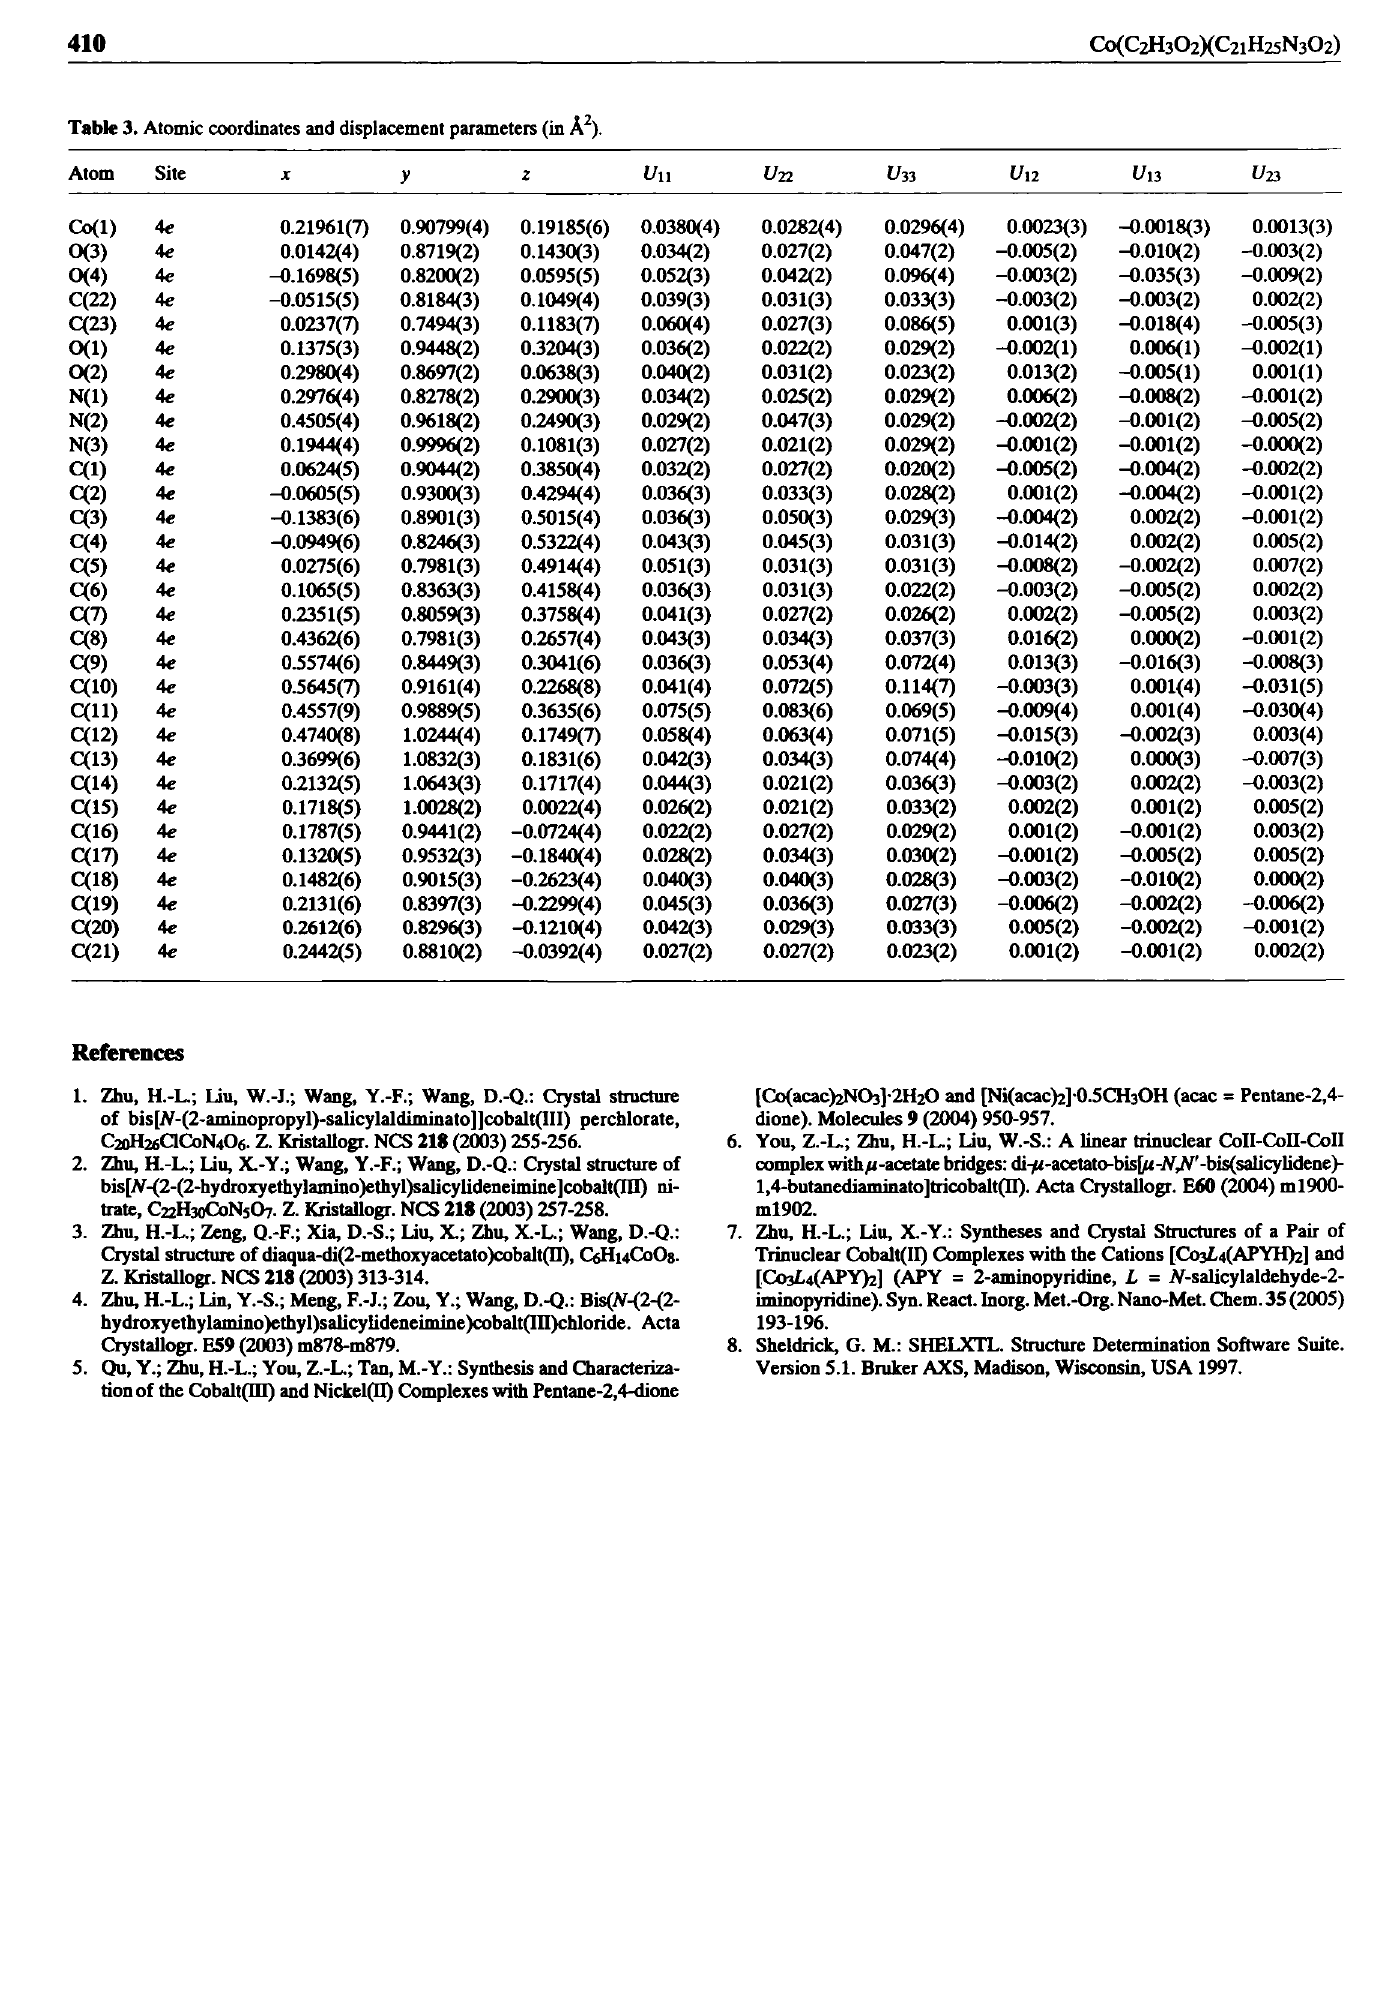
Table 3. Atomic coordinates and displacement parameters (in Ä 2